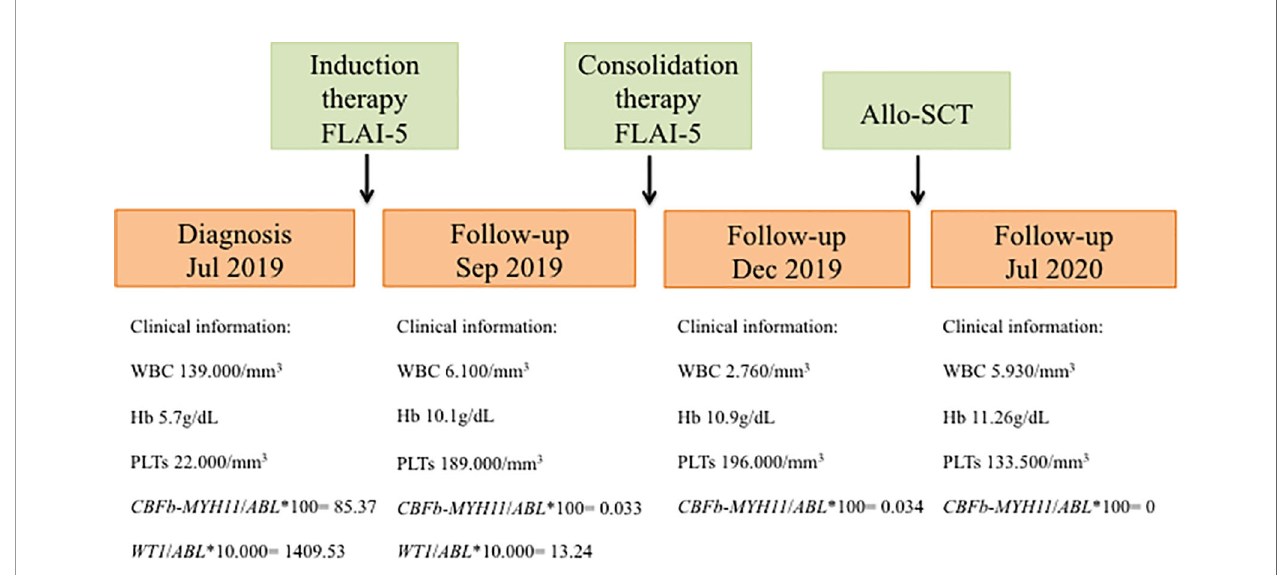
FIGURE 1 | Schematic representation showing timeline of treatment course and clinical information. FLAI-5, fl udarabine-cytarabine-idarubicin; Allo-SCT, allogeneic stem cell transplantation; WBC, white blood cells; Hb, hemoglobin; PLTs,